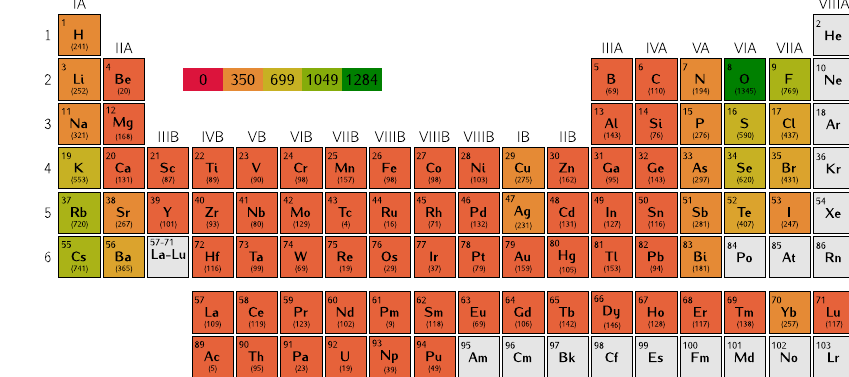
Fig. 4 Distribution of semiconductors and insulators. The number of stable semiconductors and insulators containing the given chemical element of the periodic table.